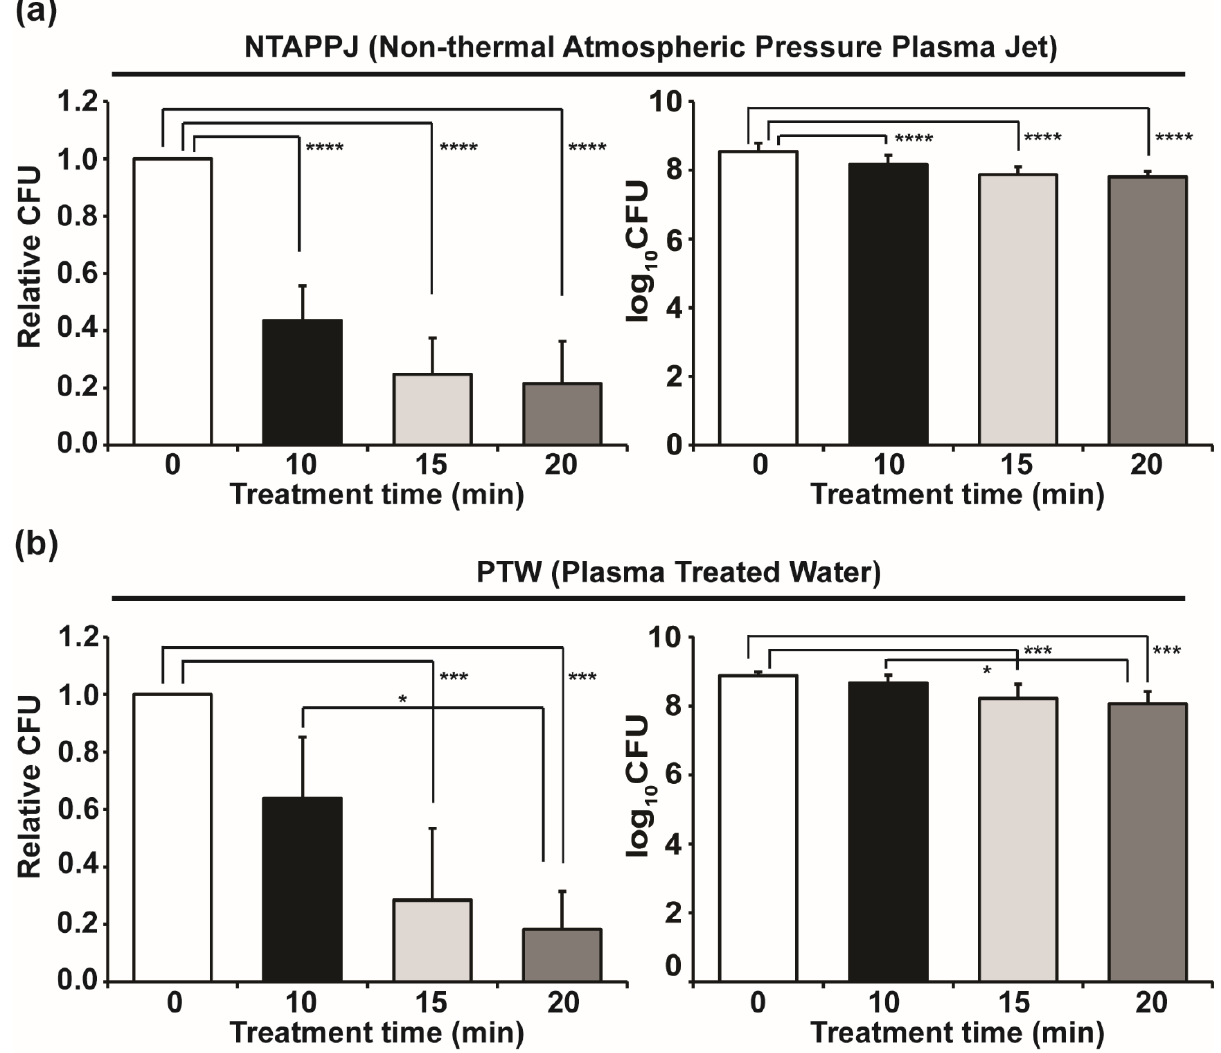
Figure 2. Viability of E. coli extracted from inoculated mushroom after treated with NTAPPJ ( a ) and PTW ( b ). Each value is the average of 9 (PTW) and 12 (NTAPPJ) replicate measurements. Only significantly different groups were indicated; * p < 0.05, *** p < 0.001, **** p < 0.0001.